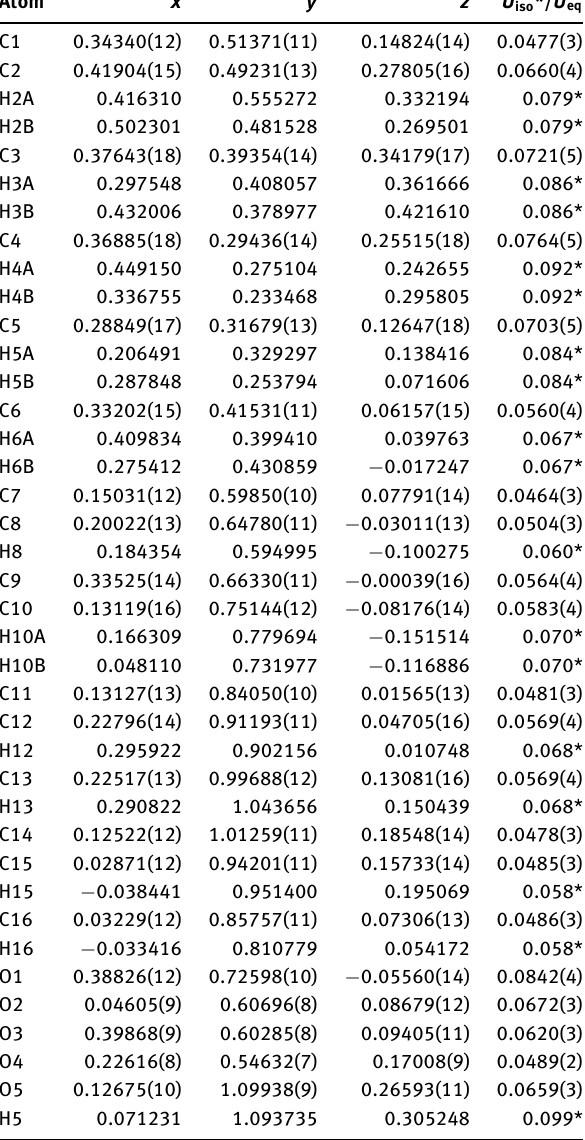
Table 2: Fractional atomic coordinates and isotropic or equivalent isotropic displacement parameters (Å 2